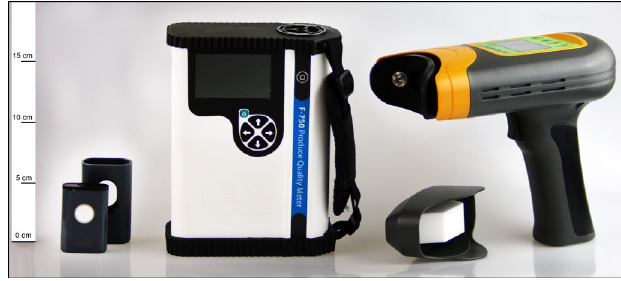
Fig. 1: Commercially available portable NIR food-scanner: (left) SCiO™ Molecular Sensor with protective plastic case, (middle) F-750 Produce Quality Meter, (right) H-100F portable spectrometer with protective plastic cap.